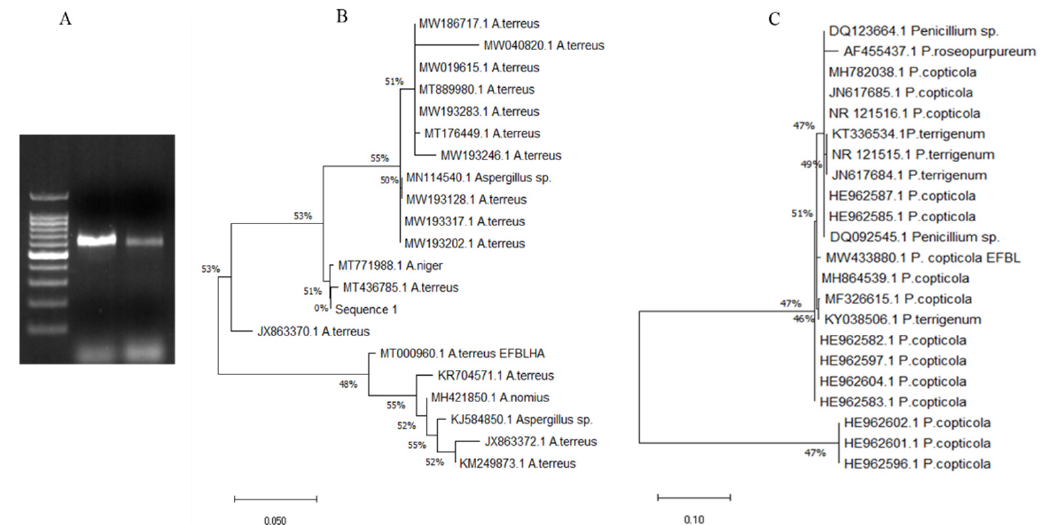
Figure 1. Molecular identification of the potent tyrosinase producing endophytic fungal isolates inhabiting Moringa oleifera. ( A ) , PCR amplicons of ITS regions of the experimented fungal isolates using genomic DNA as template for PCR with the primers ITS4 and ITS5. Molecular phylogenetic analyses of Aspergillus terreus ( B ) and Penicillium copticola ( C ) by the maximum likelihood model of MEGA 7.0 package.